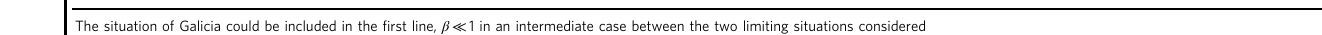
Table 1 Different possible combinations for the parameters α and β α ≪ 1 α ≫ 1 β ≪ 1 Sparse, egalitarian. Internal dynamics dominate. Well connected, egalitarian. β ≫ 1 Sparse, non egalitarian. Well connected, non-egalitarian. Network dynamics